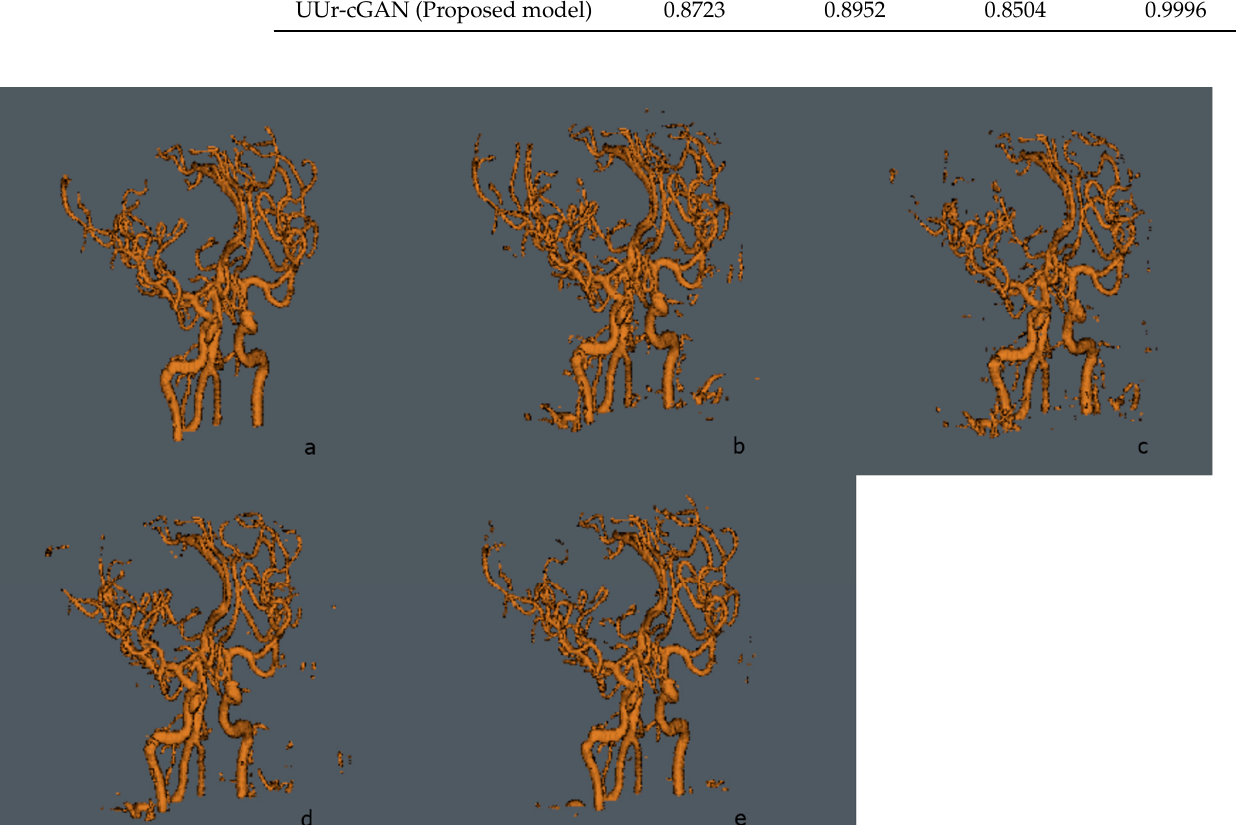
Figure 7. Segmentation map obtained from each one of the evaluated methods described in Table 2, using data from the first fold of the cross-validated experiment. 3D Visualizations were generated by the software Aliza Medical Imaging ©, Bonn, Germany, and DICOM Viewer for ground truth and prediction volumes. ( a ) Ground truth, ( b ) U-Net [22], ( c ) Pix2Pix [33], ( d ) Concatenated U-Net and residual U-Net [30], and ( e ) Proposed cGAN.